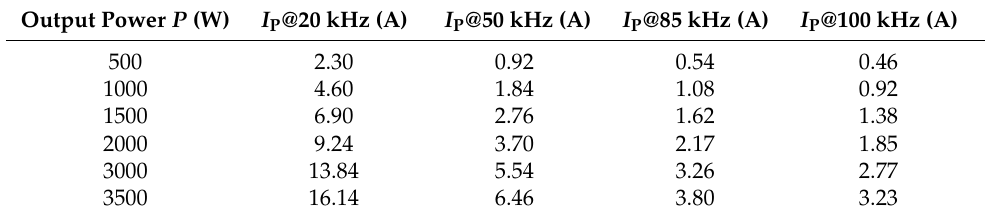
Table 4. Resonant current values at various frequency and power